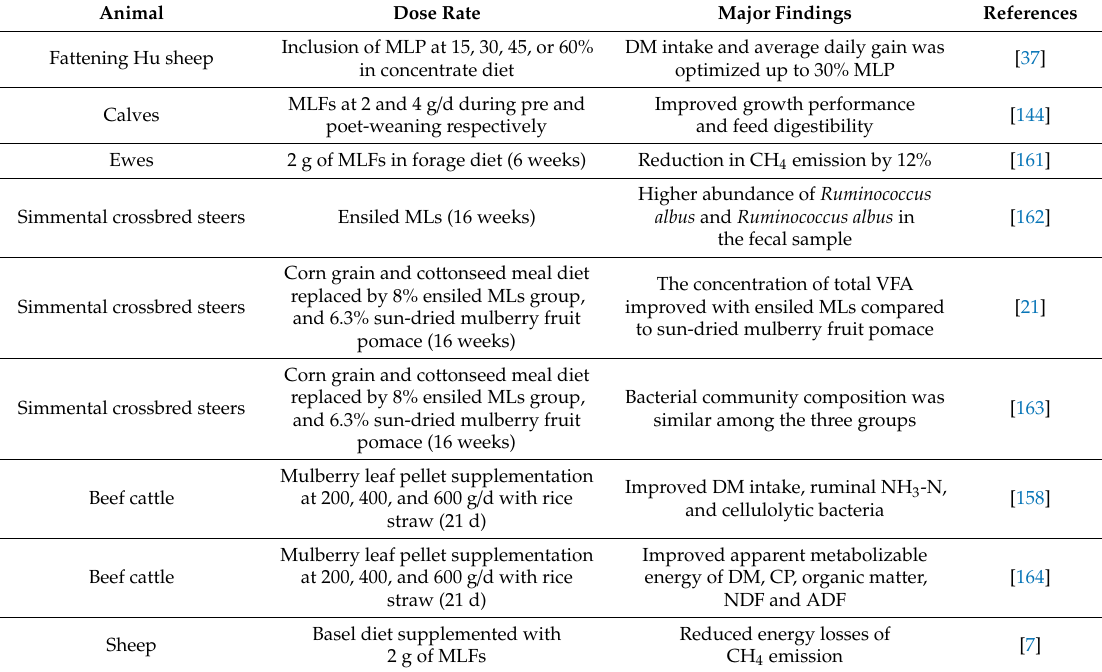
Table 4. E ff ect of mulberry leaf biomass and its flavonoids on ruminant performance. Animal Dose Rate Major